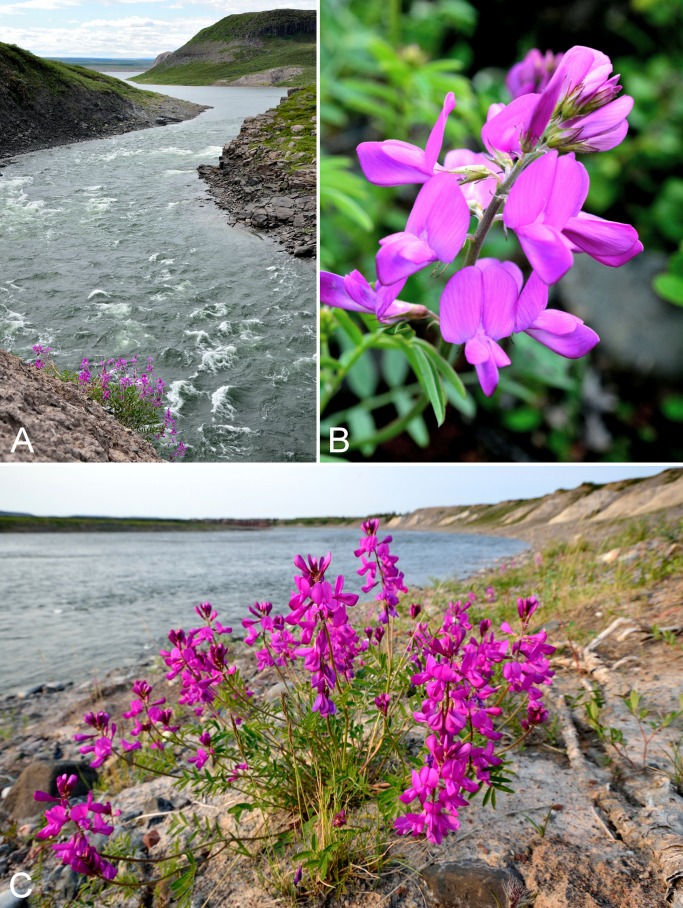
Hedysarum boreale subsp. mackenziei.(A) Habitat, Kugluk (Bloody Falls) Territorial Park, Nunavut, 19 July 2014. (B) Inflorescence, Saarela et al. 3377. (C) Habit, Saarela et al. 3377. Photographs by R. D. Bull (A, C) and P. C. Sokoloff (B).